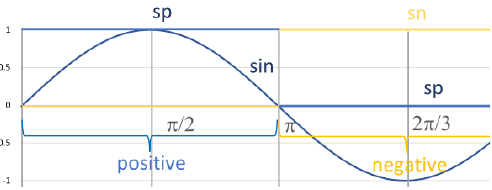
Figure 2. Diagram of sin and the characteristic function 1 { x ∣ 0 ⩽ sin ( x )}